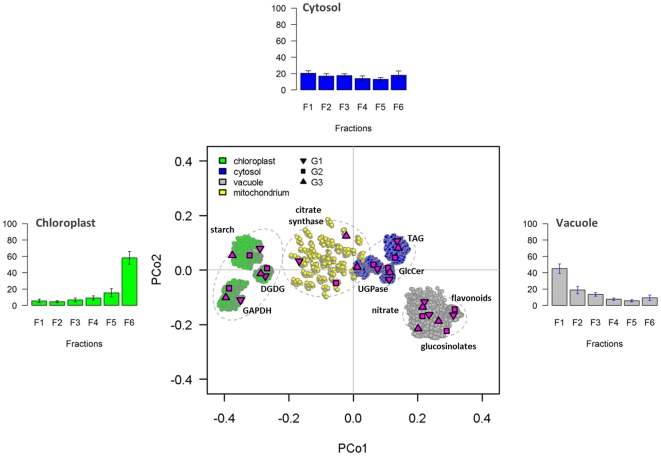
Consistency and robustness of compartmental separation within and between gradients.Manhattan distances among markers for each gradient were converted into a principal coordinates (PCo) space using classical multidimensional scaling (CMD) for the three independent and 729 non-redundant combinations of randomly assembled gradients. Shapes colored in magenta show the data points for the three independent gradients (G1, G2, and G3 as depicted in the figure) of each selected marker. Data points from simulated gradients are depicted as circles with coloration according to the individual compartments: green – chloroplasts, blue – cytosol, and grey – vacuole. For each compartment the 95% confidence ellipse is drawn as a dashed grey line on the basis of the mean, standard deviation, and correlation of the 729 non-redundant gradient combinations. The mitochondrial compartment (yellow circles) shows an overlapping distribution with the cytosol where the majority of data are in between the plastidic and cytosolic compartments. The principal coordinates 1 and 2 explain together in average about 96.7% of the total variance of the underlying distance matrices. For each of the three resolved compartments the distribution of average abundances including their standard deviations throughout the three independent gradients is depicted as bar plots.